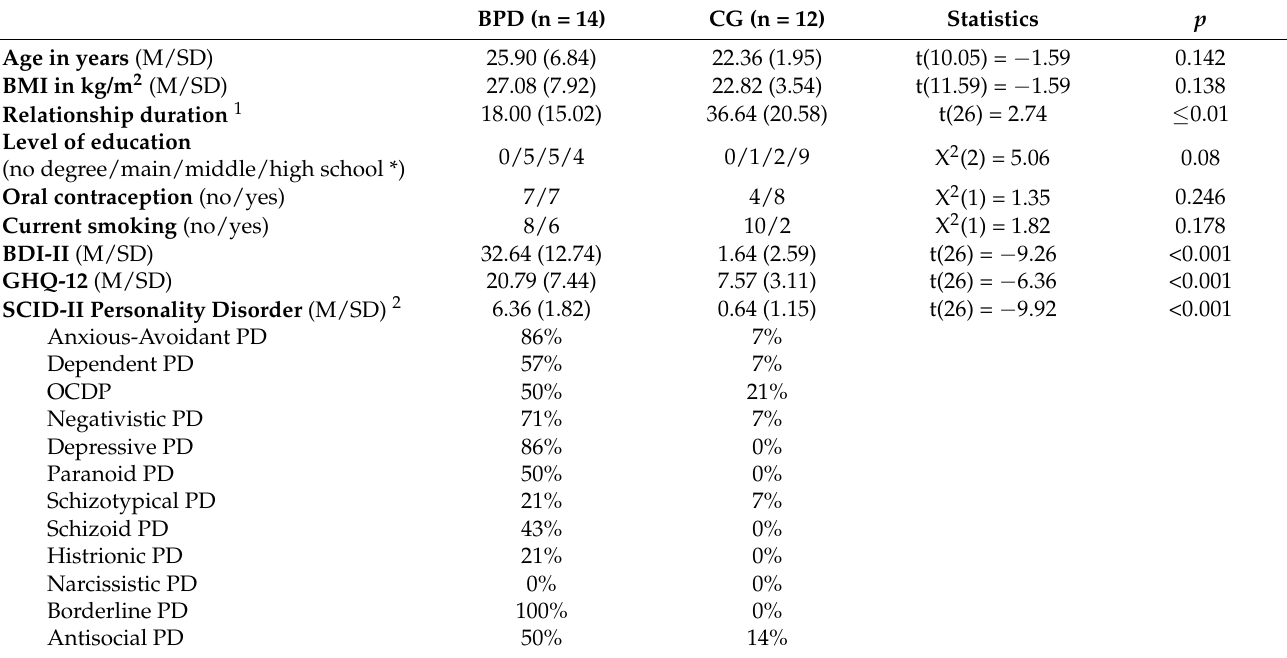
Table 1. Sample characteristics for female